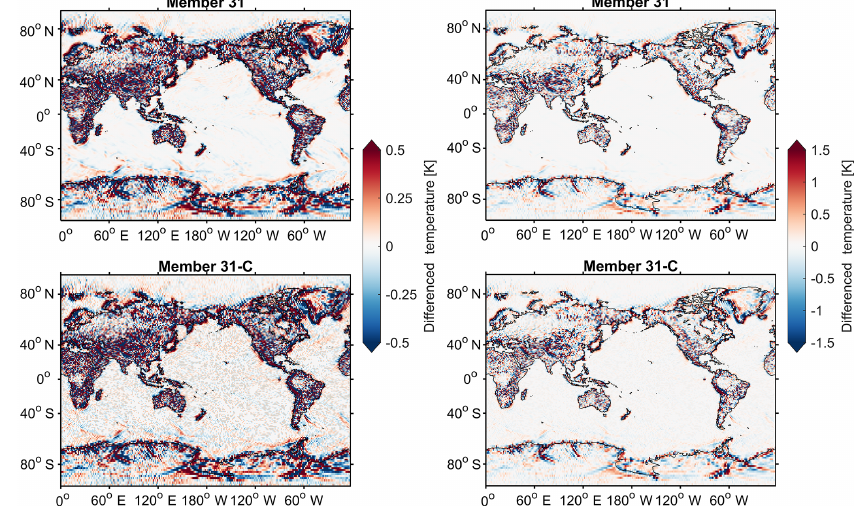
Figure 12. A comparison of the difference maps (i.e., gradients) for the surface temperature field (TREFHT) for ensemble members 31 (original) and 31-C (reconstructed) for October 1920. Note that the color scale for the left maps has a smaller range than for the right maps.